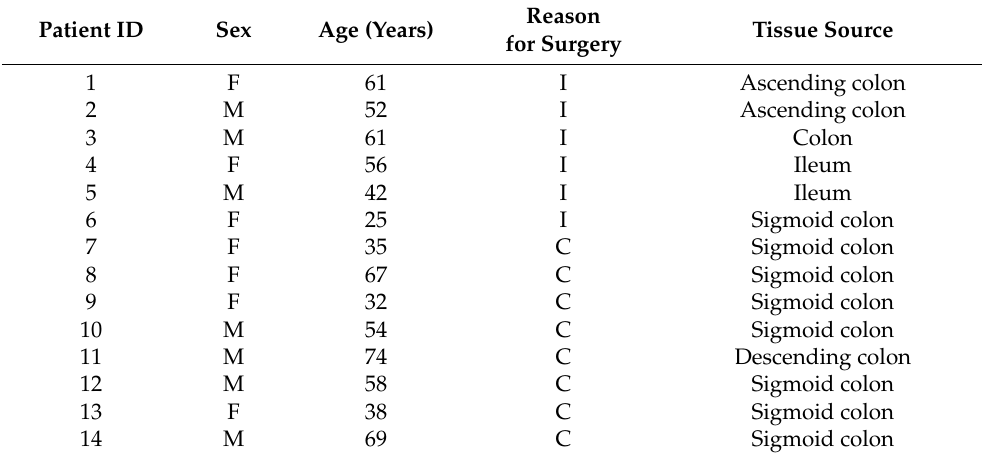
Table 2. Composition of the Non-Multiple Sclerosis Control Patient Cohort.